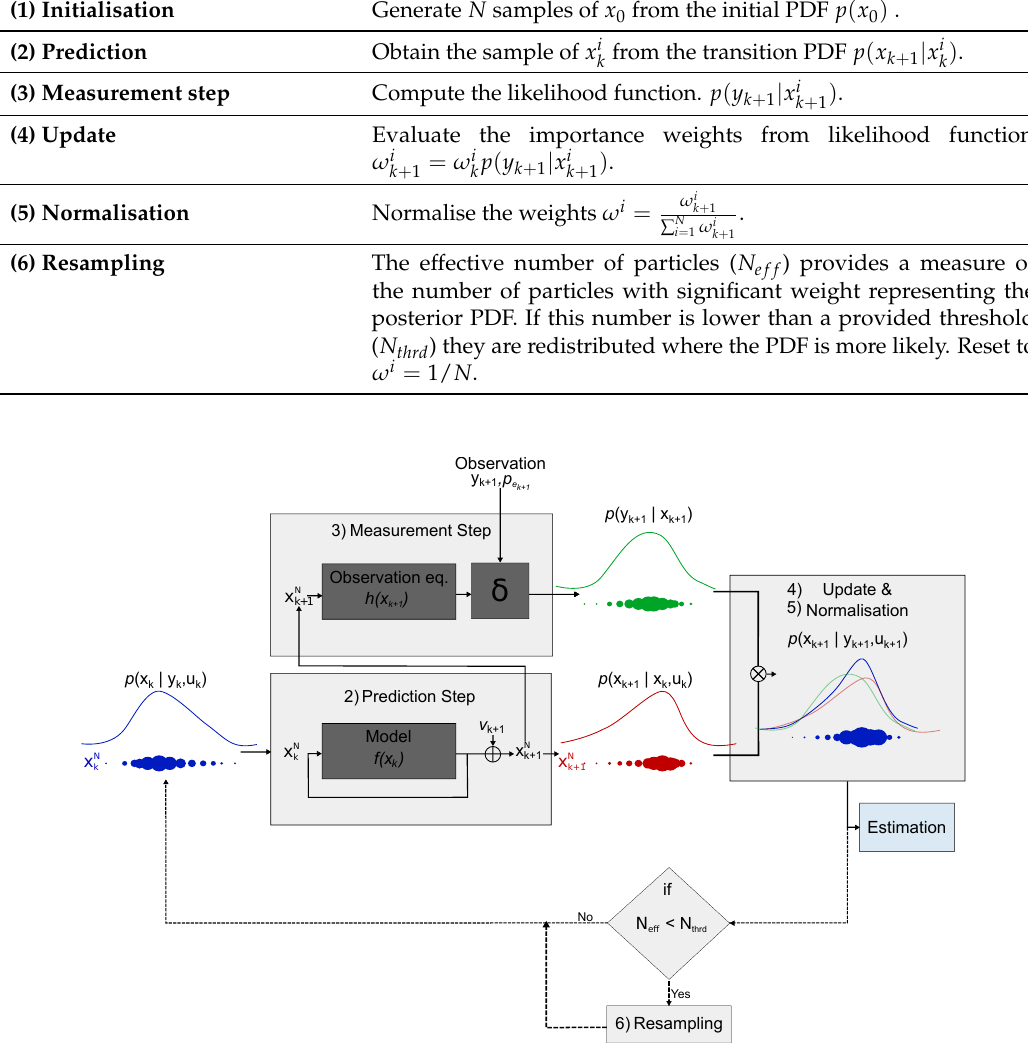
Figure 1. Representation of the steps involved in the estimation algorithm based on the particle filter. The initialisation (step 1) is omitted because it is not part of the iterative